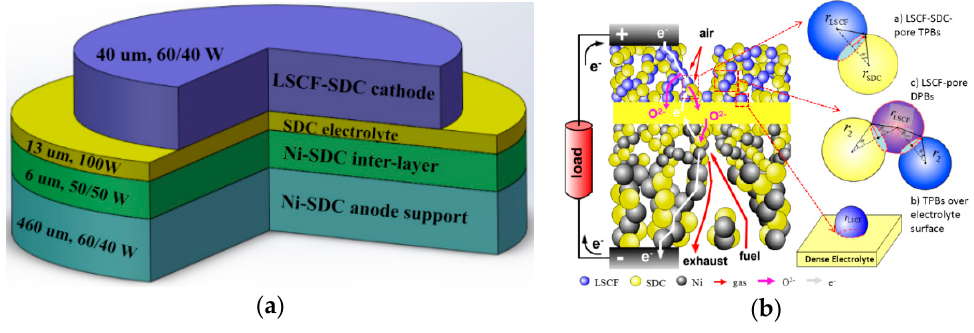
Figure 1. ( a ) The sketch figure of a typical LSCF-SDC/SDC/Ni-SDC IT-SOFC, ( b ) the corresponding multi-physics working processes within it.